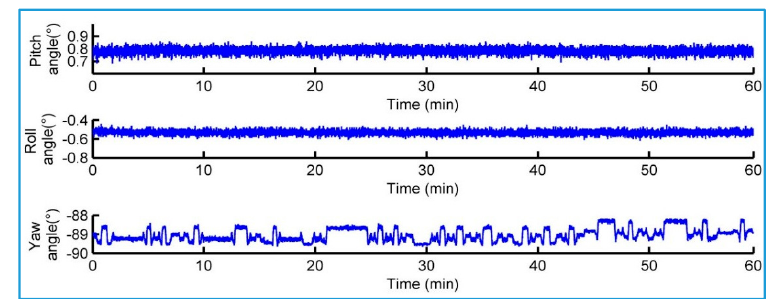
Figure 11. Attitude angle data AHRS output in static state.